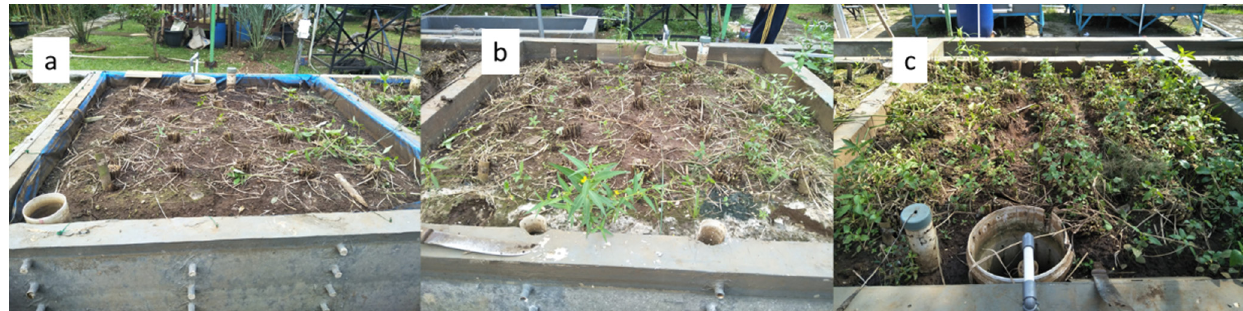
Figure 10. Weed collection after harvesting in each regime: ( a ) CFI; ( b ) MFI; ( c ) WSI.